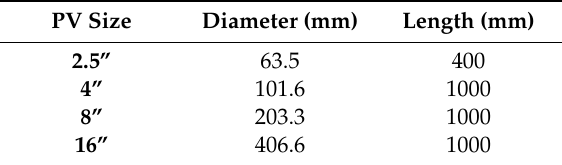
Table 1. Pressure vessel (PV) sizes used in this